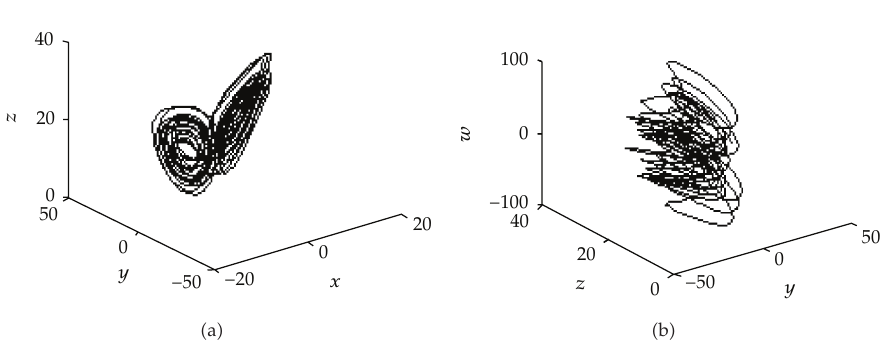
Figure 2: The phase portrait of system (cid:5) 3.1 (cid:6) chaotic attractor (cid:5) α (cid:7) 0 . 96 (cid:6) with (cid:5) a (cid:6) x,y,z and (cid:5) b (cid:6) y,z,w